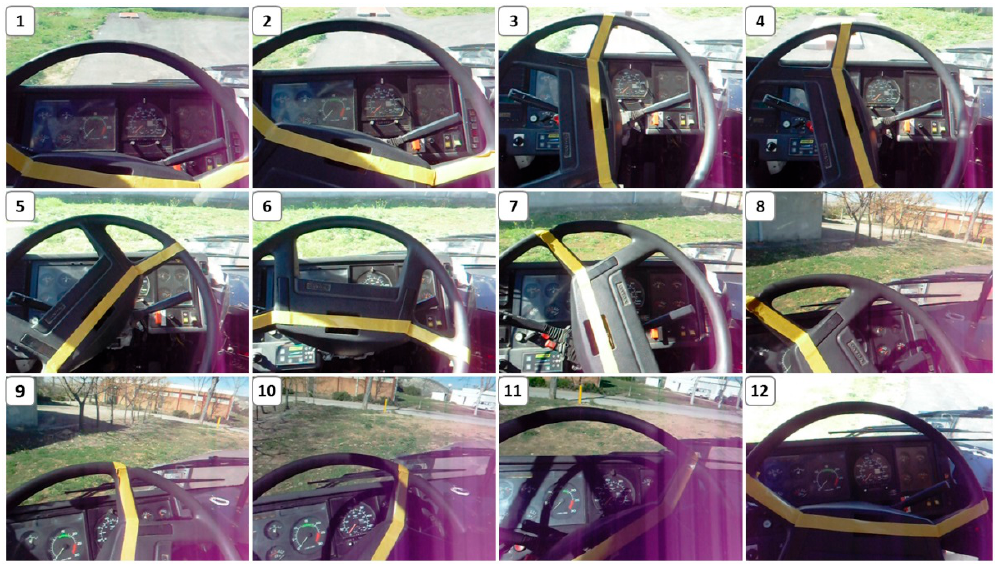
Figure 18. Details of the steering wheel during one curved section of the experimental tests.